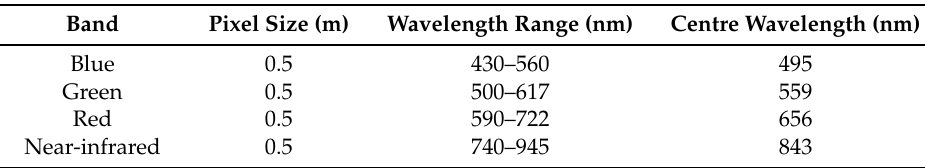
Table 3. The spectral information of Pléiades images.